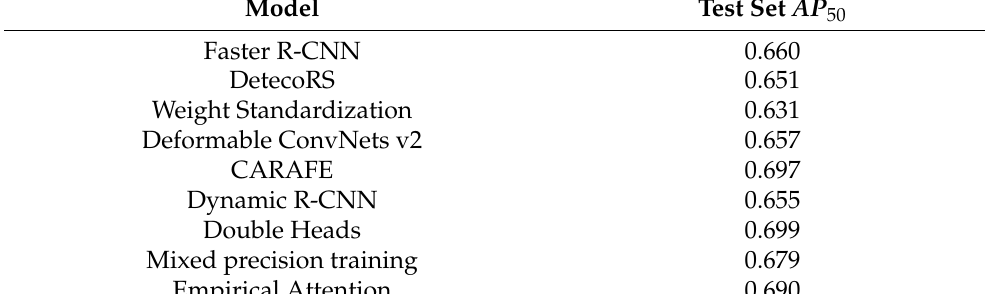
Table 4. Performance of the two-stage and multi-stage (DetectoRS) methods for the test set using AP 50 .